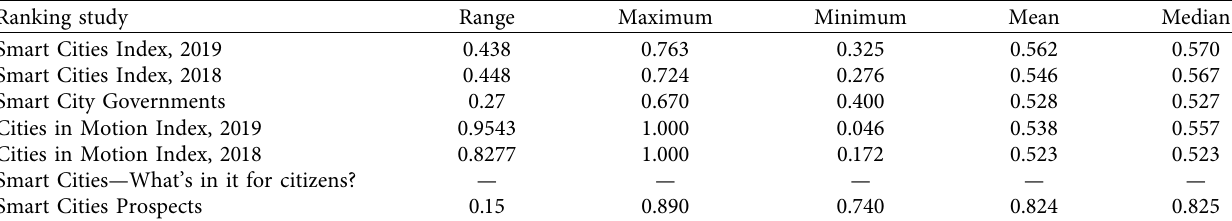
Table 8: Basic statistical analysis of the normalized scores in the 7 ranking studies considered.